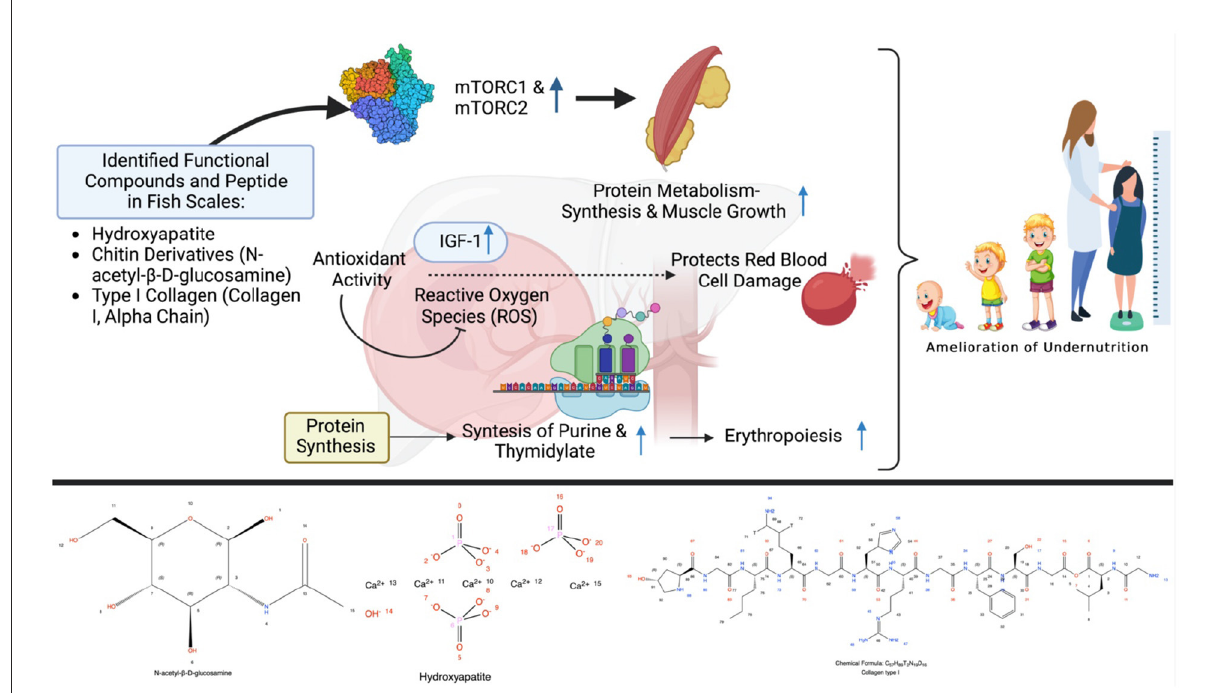
FIGURE1 Possible scheme to alleviate stunting via the modulation of the metabolism by fish scale peptide supplementation. Created with BioRender.com premium license by Fahrul Nurkolis.